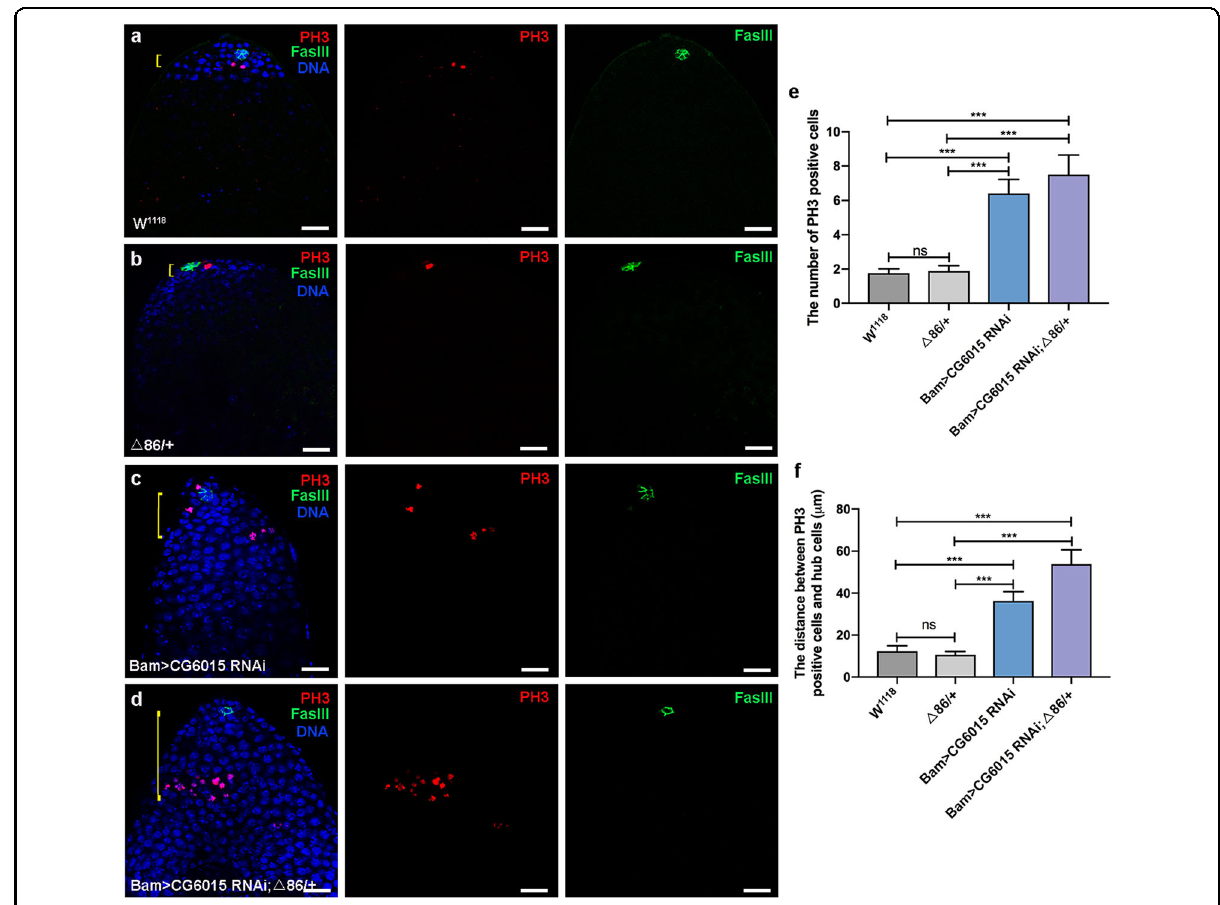
Fig. 3 Reduction of CG6015 in spermatogonia increased proliferation in Drosophila testes. a – d Immunostaining of PH3 (red) and FasIII (green) at the apex of W 1118 , Δ 86/ + , Bam> CG6015 RNAi and Bam> CG6015 RNAi; Δ 86/ + testes. DNA was stained with Hoechst (blue). Yellow lines represented the distance between PH3 positive cells and hub cells. e The number of PH3 positive cells in W 1118 ( n = 12), Δ 86/ + ( n = 9), Bam> CG6015 RNAi ( n = 10) and Bam> CG6015 RNAi; Δ 86/ + ( n = 10) testes. f The distance between PH3 positive cells and hub cells in W 1118 ( n = 12), Δ 86/ + ( n = 9), Bam> CG6015 RNAi ( n = 11) and Bam> CG6015 RNAi; Δ 86/ + ( n = 10) testes. *** P < 0.001, ns. not signi fi cant. Scale bars: 20